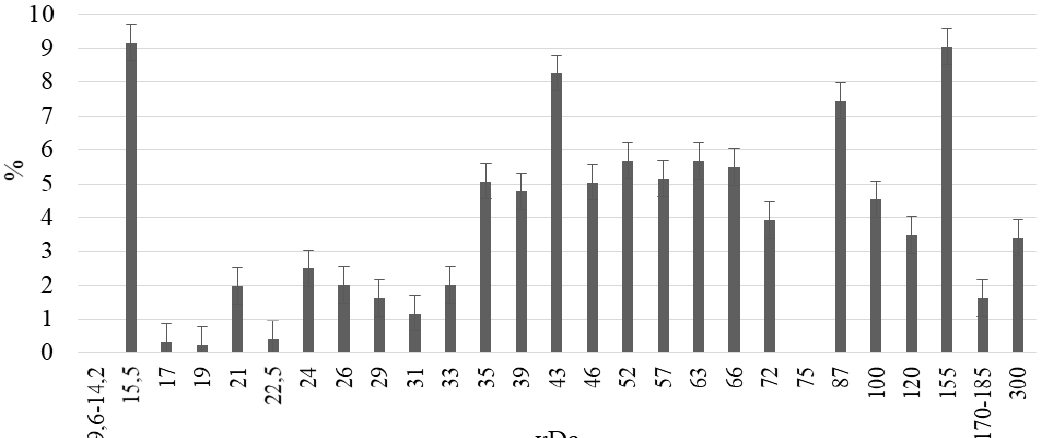
Fig. 6. Structural proteins of the basolateral membrane of the jejunum enterocytes of nine-month-old cattle fetus (M ± m; %; n =